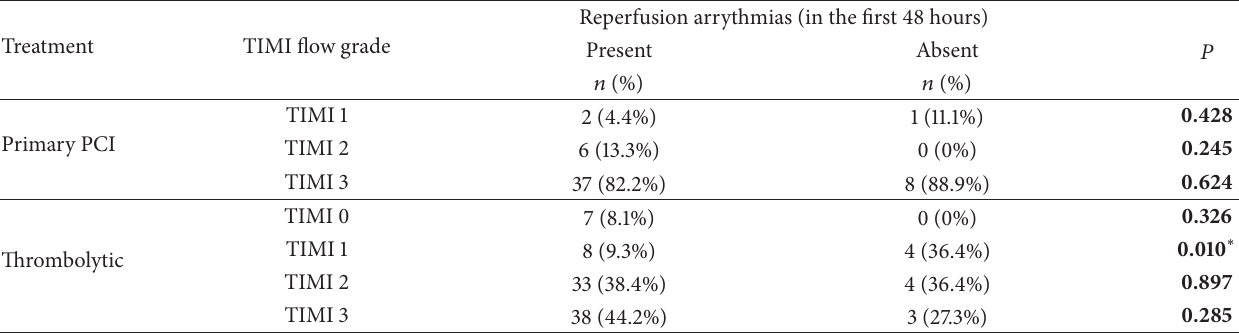
Table 6: The relationship between presence of reperfusion arrythmias and TIMI flow grades in different treatment groups. Treatment TIMI flow